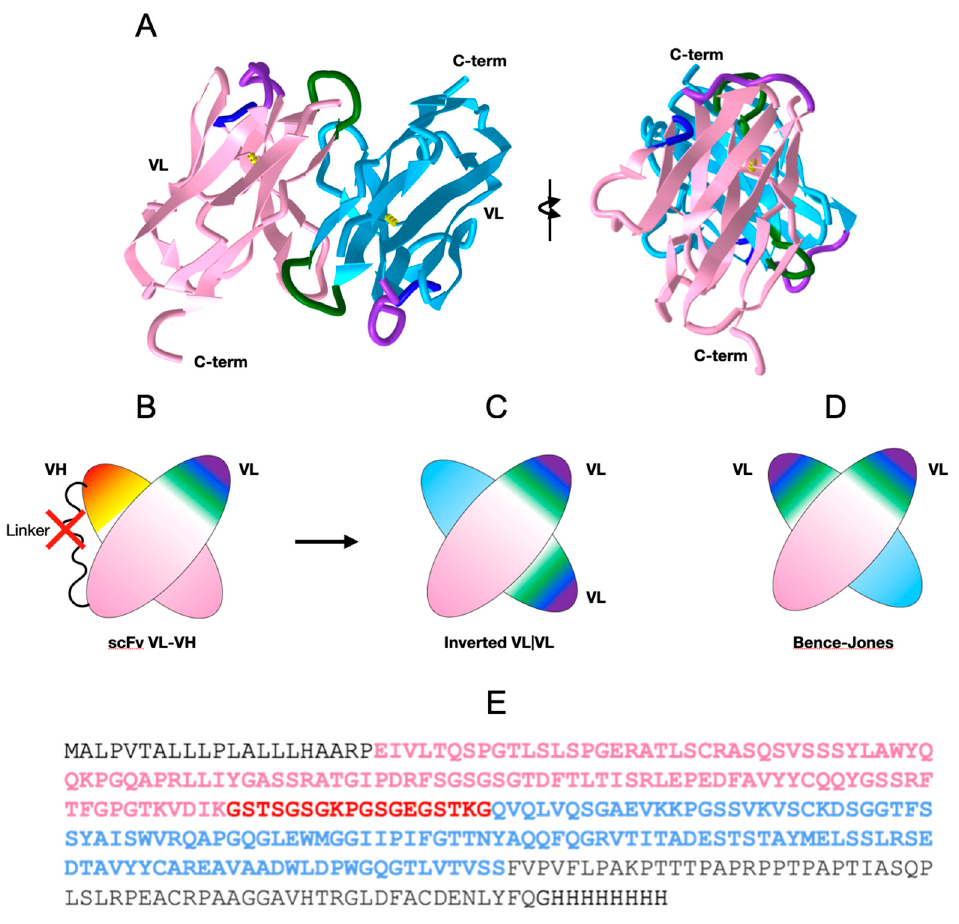
Figure 2. 47G4-CD828Z CAR domains and the VL-VL dimer. ( A ) VL-VL homodimer observed in the crystal with an inverted configuration. VL domains’ CDR1 colored in purple, CDR2 in blue, and CDR3 in green. (PDB:7JO8 3D visualization link: https://structure.ncbi.nlm.nih.gov/icn3d/share.html?mMva3qCc76kn11LG6, accessed on 19 April 2023). ( B ) Cartoon of the scFv moiety,